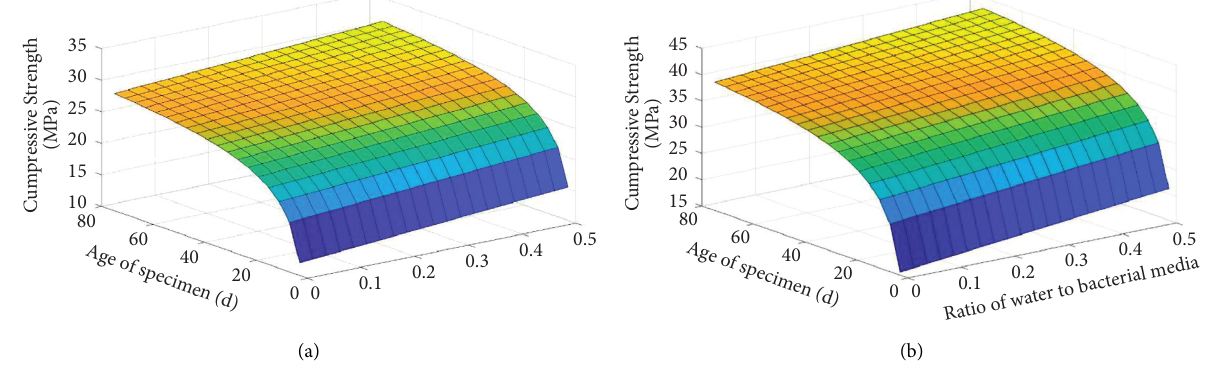
Figure 12: Response surface for